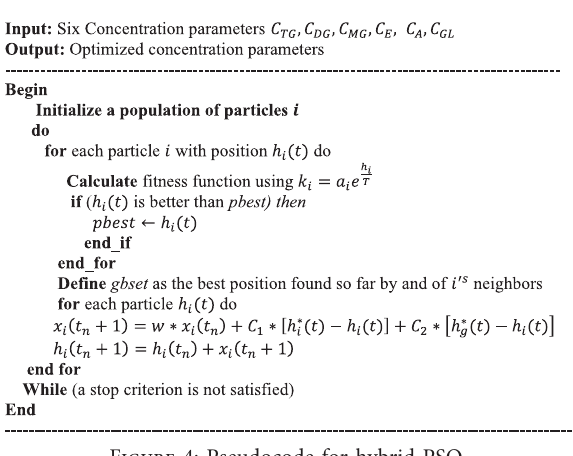
Figure 4: Pseudocode for hybrid